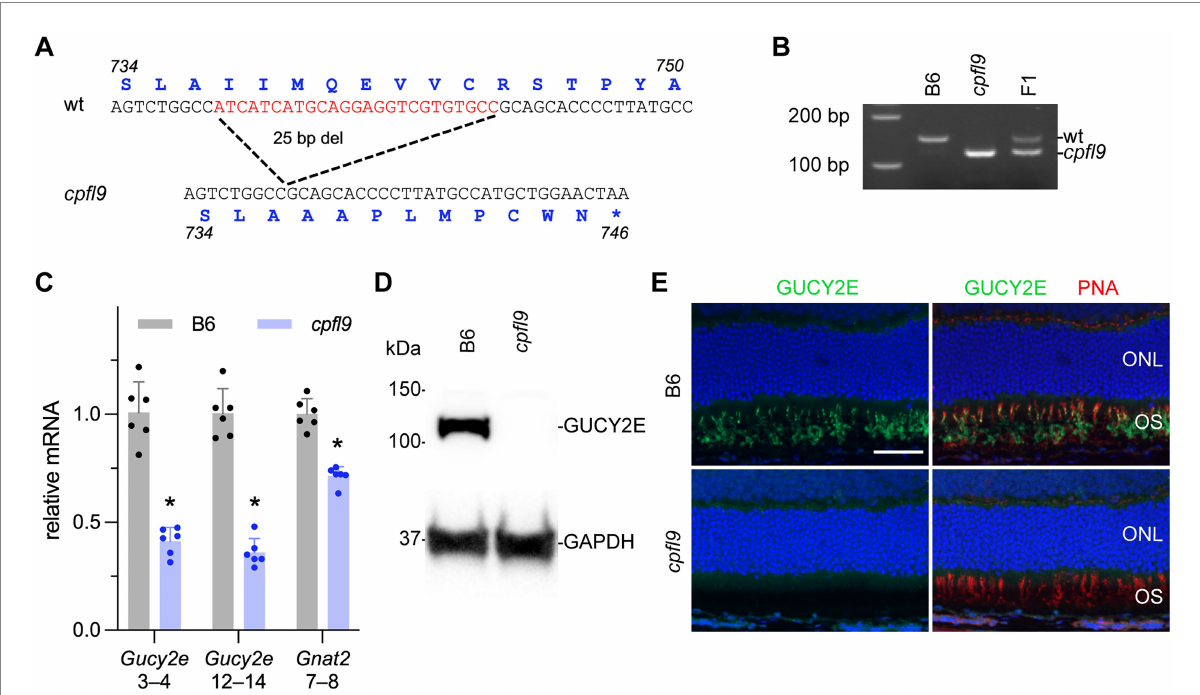
FIGURE 2 Molecular characterization of the cpfl9 mutation. (A) Comparison of wild-type reference (Ensembl, ENSMUSG00000020890, GRCm39) and cpfl9 genomic sequences of Gucy2e exon 11. A 25-bp deletion was observed in cpfl9 mutant (shown in red). Corresponding amino acid sequences from Gucy2e -201 transcript are shown in blue. (B) Genotyping of homozygous cpfl9 , B6 and F1 DNA by standard PCR/gel electrophoresis detects the WT allele at 144 bp and the mutant allele at 119 bp. F 1 mice are heterozygous carrying one copy of each WT and mutant allele. (C) Quantitative RT-PCR of retinal lysates at P18 was performed using primers specific for Gucy2e (exons 3–4 and exons 12–14) and Gnat2 (exons 7–8). The mean fold-change value ± standard error is shown. B6 ( n = 6), gray; cpfl9 ( n = 6), blue; circles represent the values from individual mice. Asterisks indicate p < 0.0005, two-tailed Student’s t-test. (D) Representative lanes of an immunoblot with anti-GUCY2E in 4-week-old B6 and cpfl9 retinal lysates. The predicted 120 kDa band was observed in B6 while absent in cpfl9 retinas. The GAPDH loading control was observed at similar levels in both samples. Lysates from n = 5 cpfl9 and n = 5 B6 mice were analyzed in separate lanes of the same blot. (E) Immunohistochemical staining with anti- GUCY2E (green) and PNA (red) shows absence of GUCY2E expression in photoreceptor OS of cpfl9 retinas compared to B6. Images are representative of n = 5 cpfl9 and n = 5 B6 mice. Scale bar, 50 μ